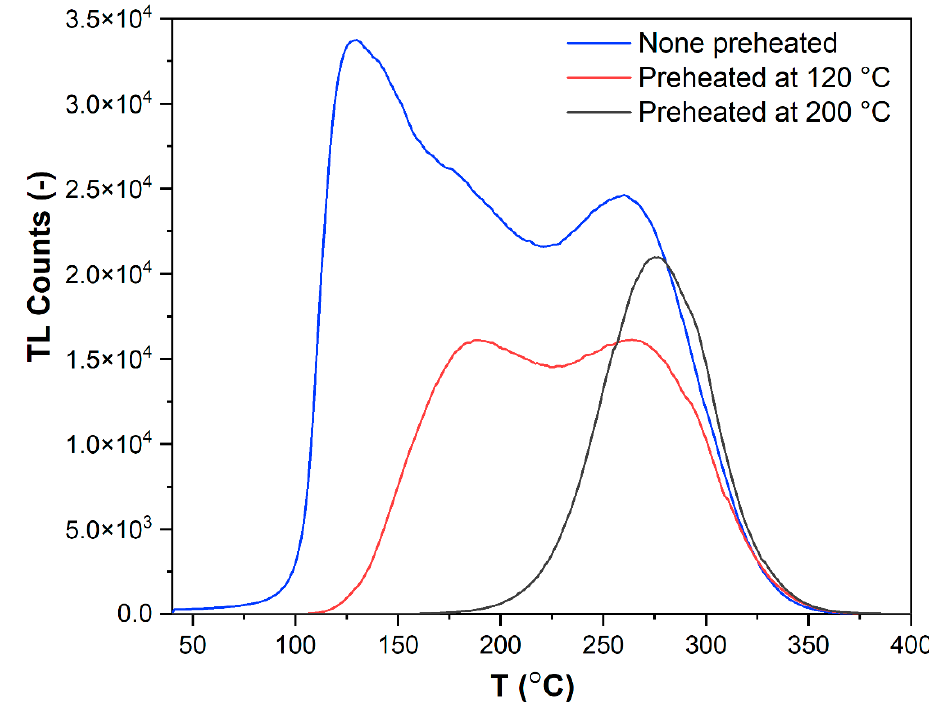
Figure 12. TL curves for PPG_Tb30 samples irradiated using beta radiation (4 μ s pulse duration), no preheating of detector, sample preheated at 120 °C, and at 200 °C; radiation dose applied ca. 30 kGy.